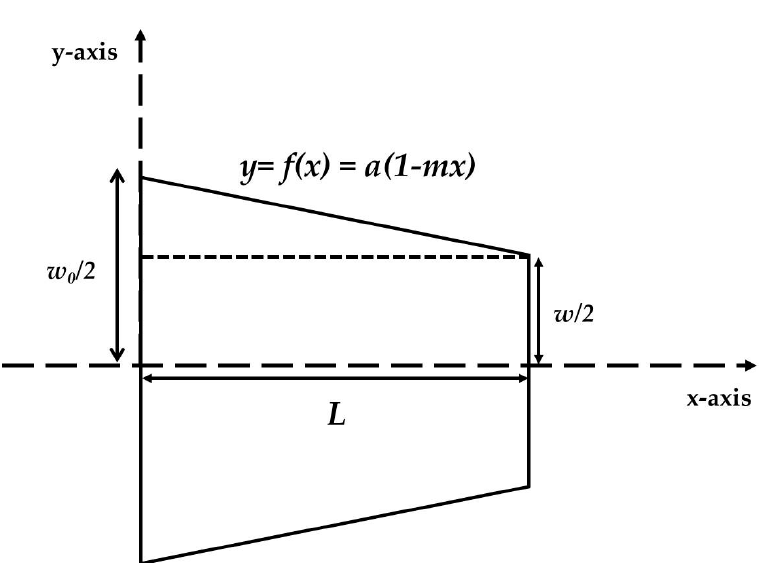
Figure 1. Schematic of the top-down view of a trapezoidal cantilever using the same notation as Sader and White [1].